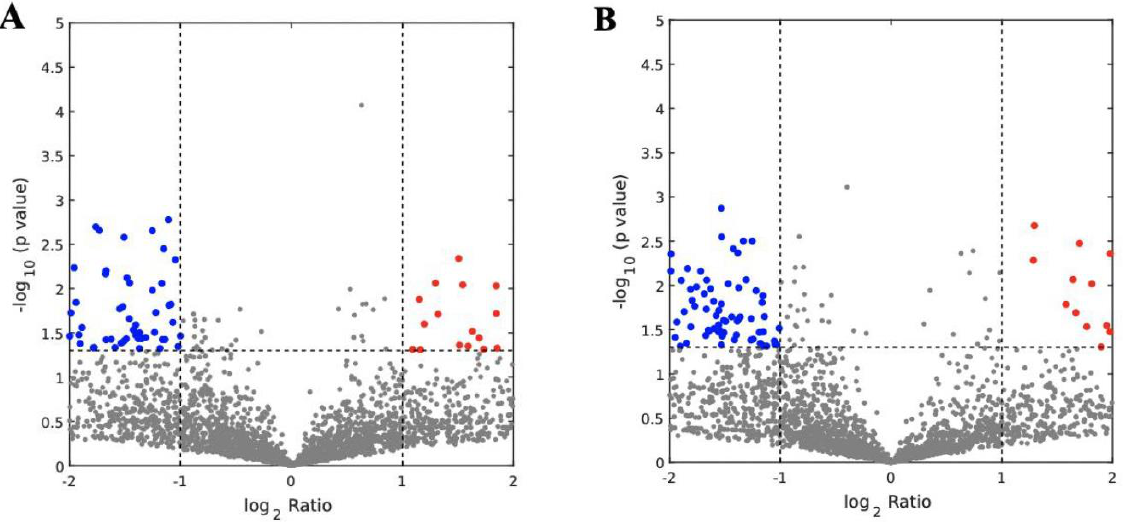
Figure 4. The abundantly expressed proteins in micro-EVs ( A ) and nano-EVs ( B ) from missed-miscarriage and healthy